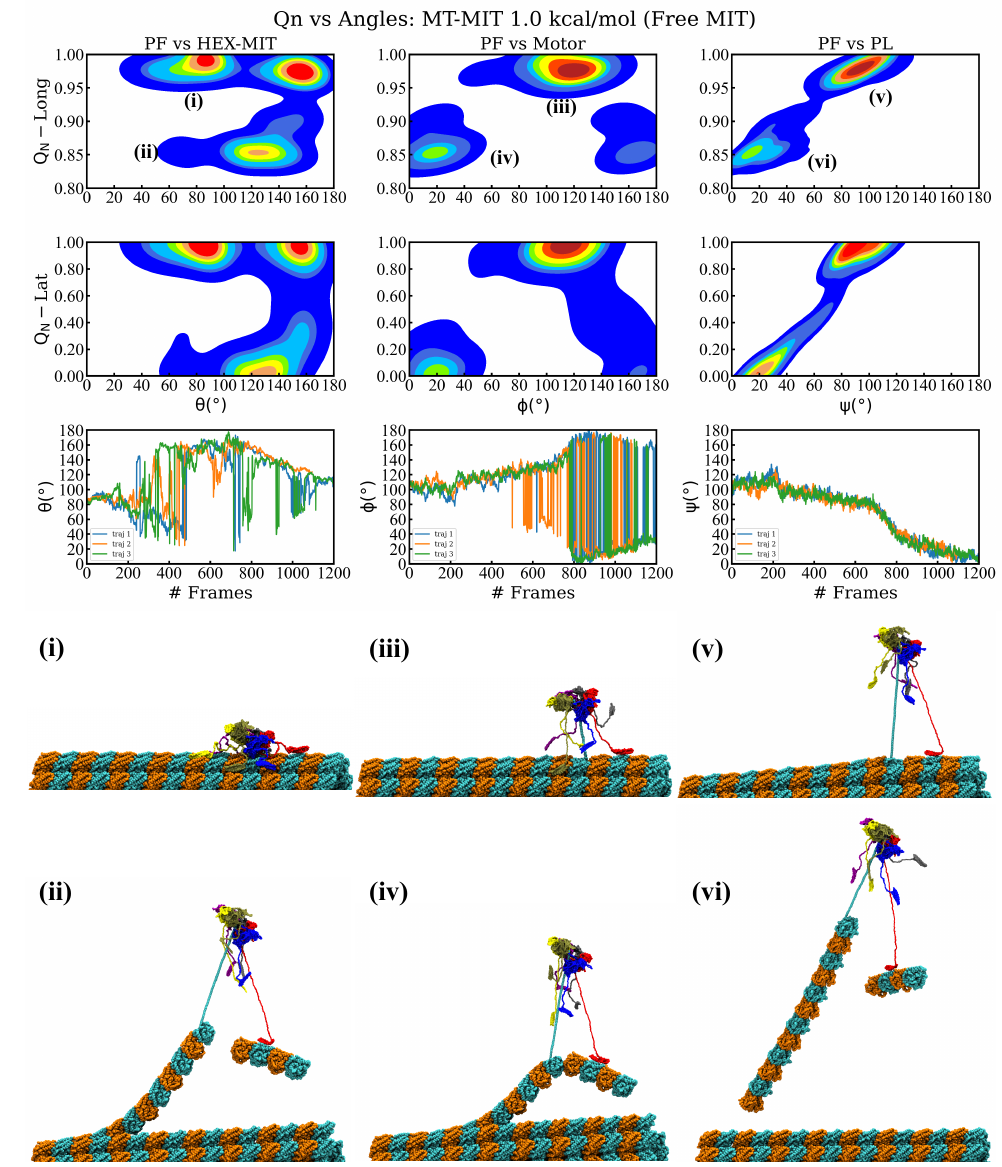
Figure 2. Results of the spastin machine acting on an MT filament for the interaction strength between its MIT domains and the MT lattice set to 1.0 kcal/mol. ( Top ) row plots show the free energy landscape in the plane of the fractional loss of longitudinal native contacts (Q N ) of the pulled protofilament (PF6) and the angle made by the principal axis of the severing enzyme (HEX-MIT), of the motor, and of the central pore loops (PL), respectively, versus the long axis of the pulled PF (PF). ( Middle ) row plots show the free energy landscape in the plane of the fractional loss of lateral native contacts of the pulled protofilament and the three angles from the top row panels. The lowest row plots depict the time evolution of the three angles from the upper plots versus the simulation frames. Instantaneous snapshots of the representative structures corresponding to the labeled minima in the free energy plots are shown at the ( Bottom